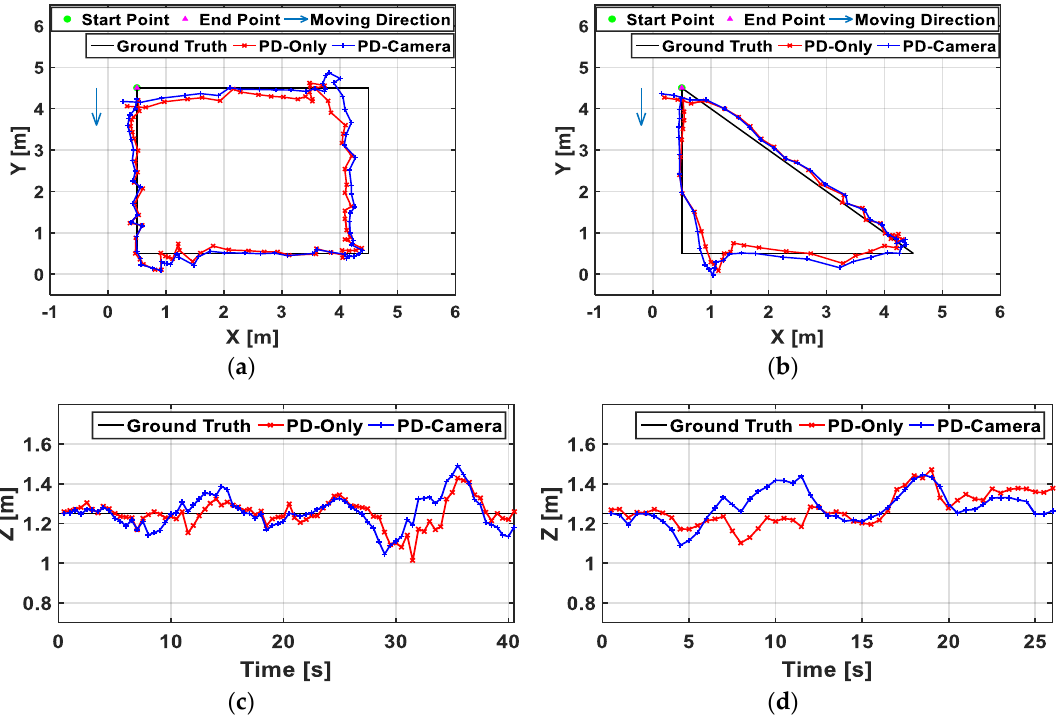
Figure 6. The estimated trajectories based on PD-only positioning and PD–camera data fusion. ( a ) Rectangle trajectory, ( b ) Triangle trajectory, ( c ) Rectangle Z-axis results, and ( d ) Triangle Z-axis results. Table 2. Positioning Errors of PD-Only Positioning and PD–Camera Data Fusion. MPE: Mean Positioning Error, RMSE: Root-Mean-Square Error.